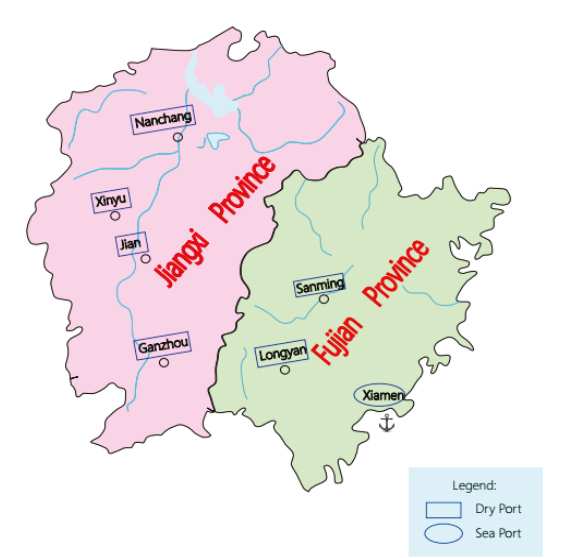
Figure 4: A diagram of Xiamen Port and her dry ports.